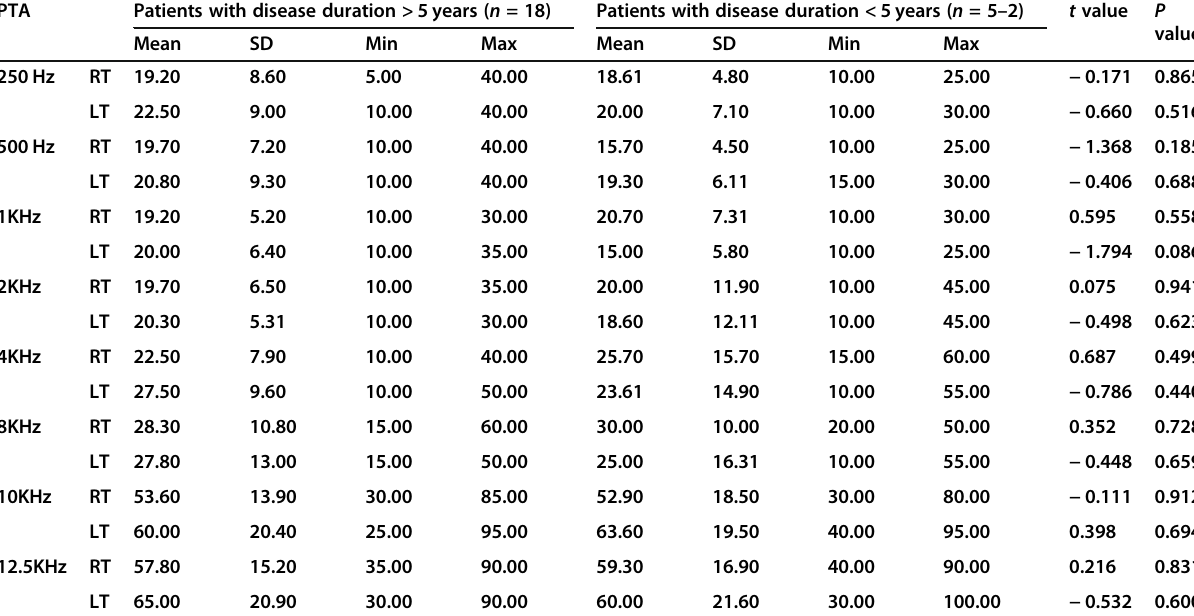
Table 5 PTA results in BD patients with disease duration > 5 years and BD patients with disease duration < 5 years PTA Patients with disease duration > 5 years ( n = 18) Patients with disease duration < 5 years ( n = 5 – 2) t value